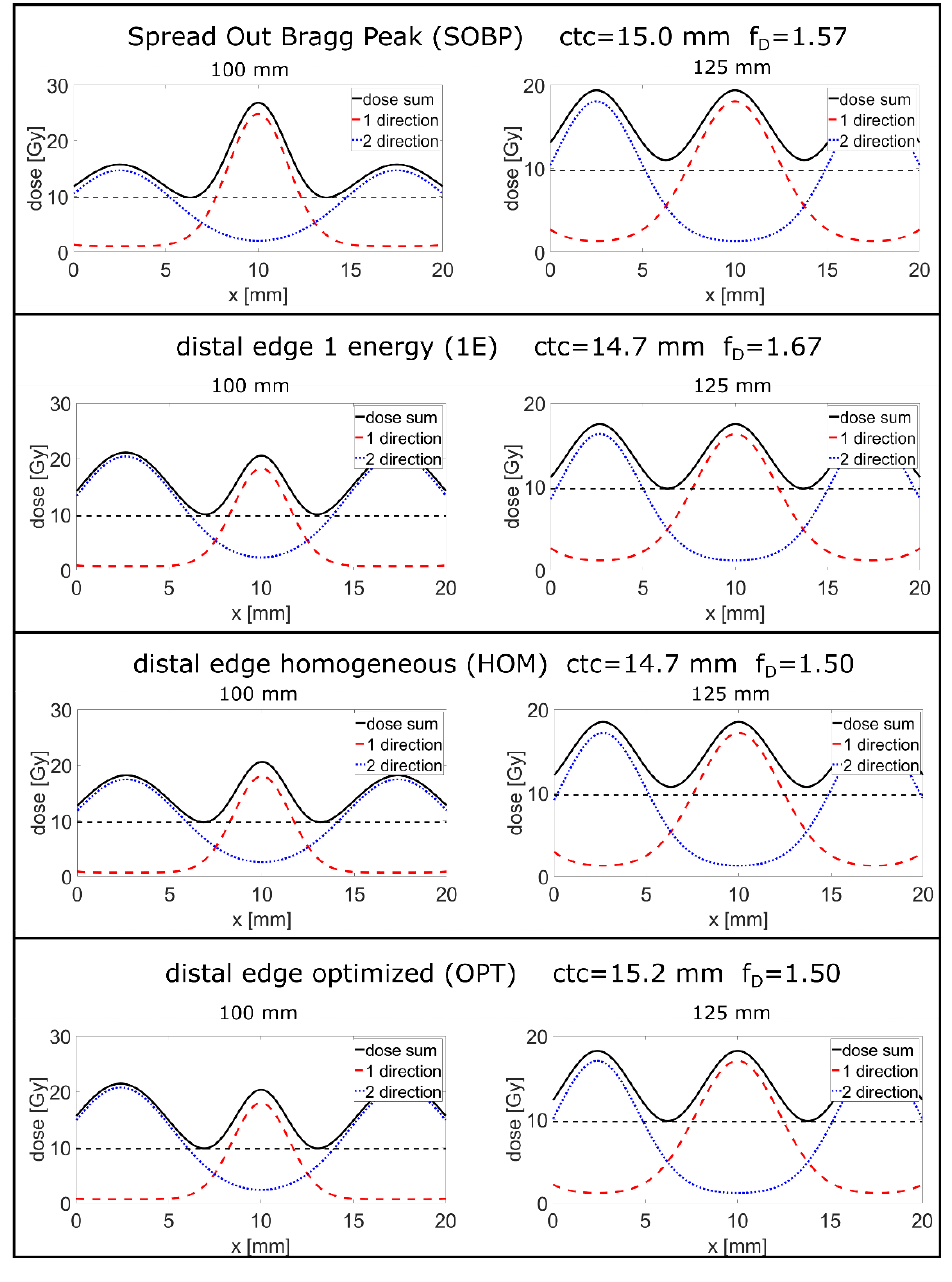
Figure 3. Cross-sections of the dose distributions of the different interlaced minibeam irradiation modes at the tumor edge at a depth 100 mm (the dashed line in Figure 2) and the tumor center at 125 mm (dashed–dotted lines in Figure 2). The dashed red lines are the cross sections of dose distributions for the irradiation applied from one direction (from left to right in Figure 2) and the dotted blue lines are coming from the opposite direction (from right to left in Figure 2). The solid black line is the dose sum of direction 1 and direction 2. The dashed black lines mark the minimum dose criterion of 0.975 × D t = 9.75 Gy.